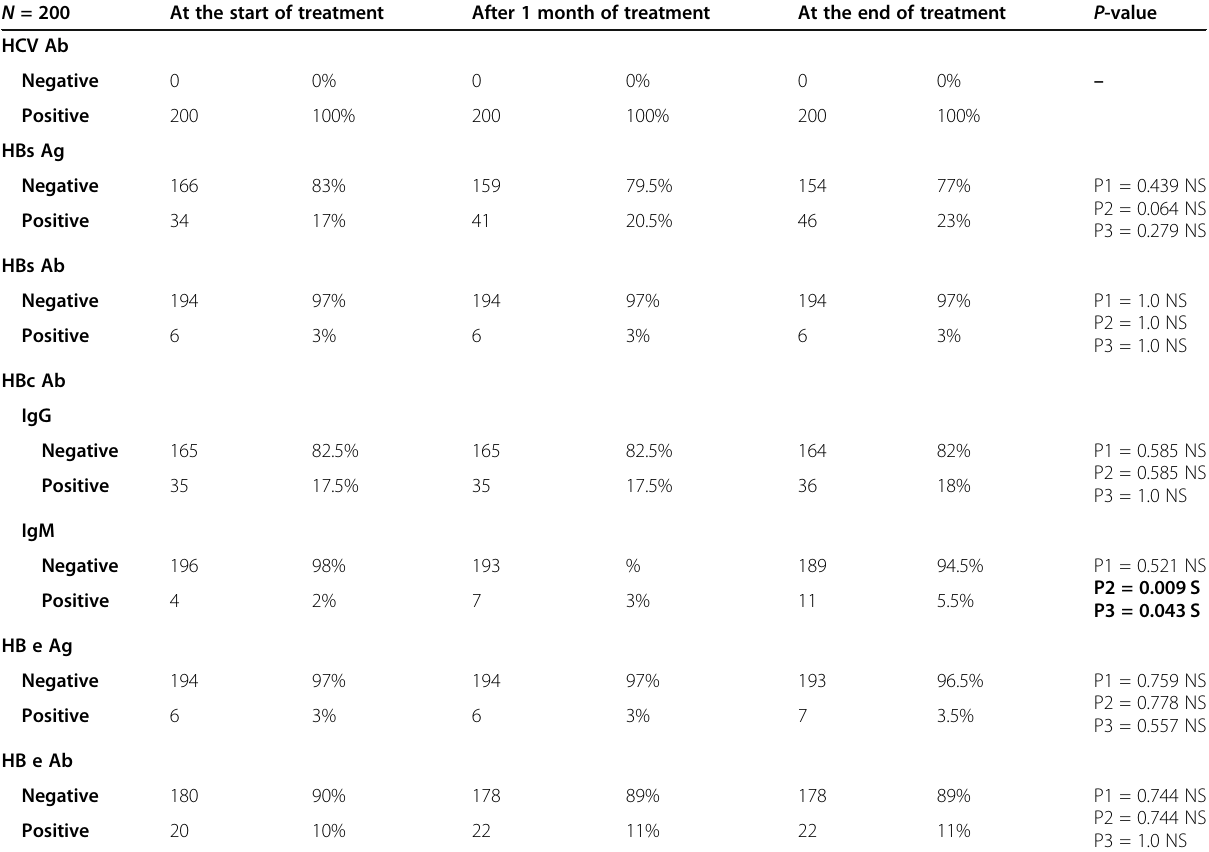
Table 5 Comparison between hepatitis virology markers in the studied patients N = 200 At the start of treatment After 1 month of treatment At the end of treatment P -value